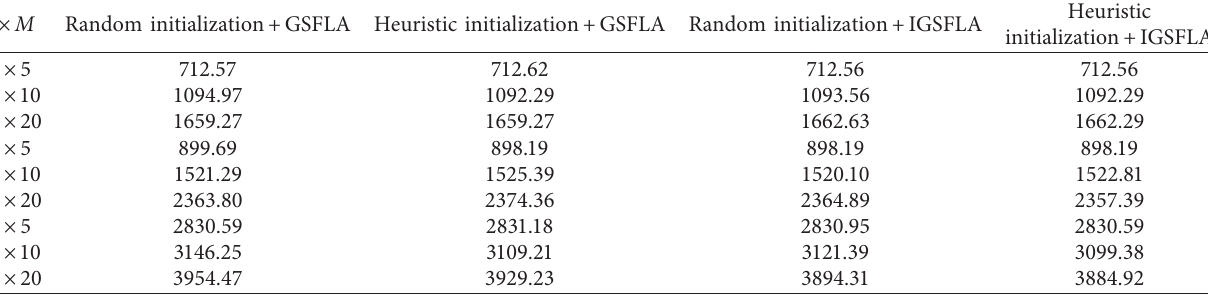
Table 3: The average value of makespan under two different initialization methods (unit: second). N × M